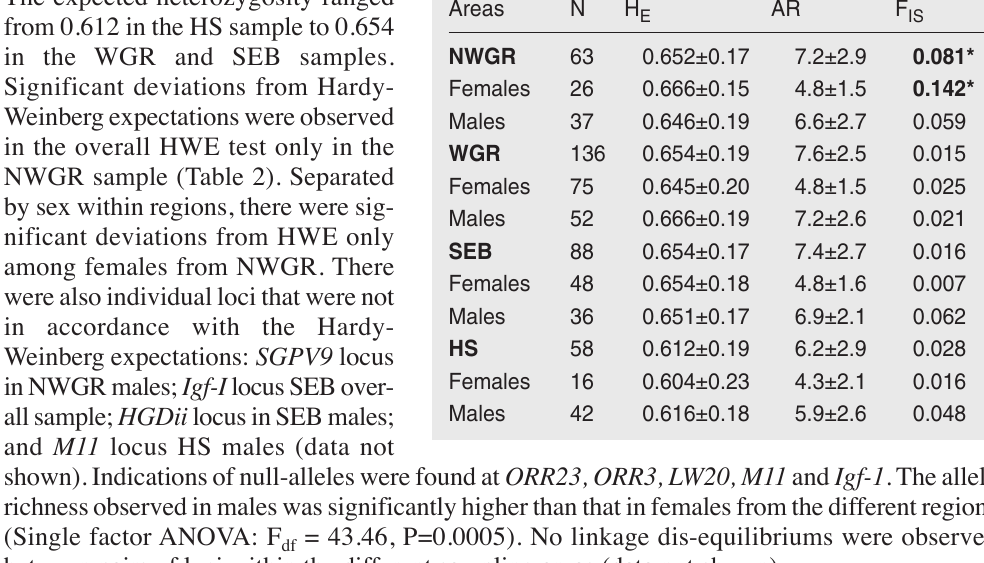
Table 2. Number of individuals (N), expected (H E ) het- erozygosity, allele richness (AR), deviations from HWE (F IS ) for the 17 polymorphic microsatellite loci used to study genetic variation in the four areas in the Davis Strait- Baffin Bay region. NWGR = Northwest Greenland, WGR = West Greenland, SEB = SE Baffin Island, HS = Hudson Strait.* BOLD : significant deviations from HWE after application of the Bonferroni procedure at α = 5% level. Areas F IS